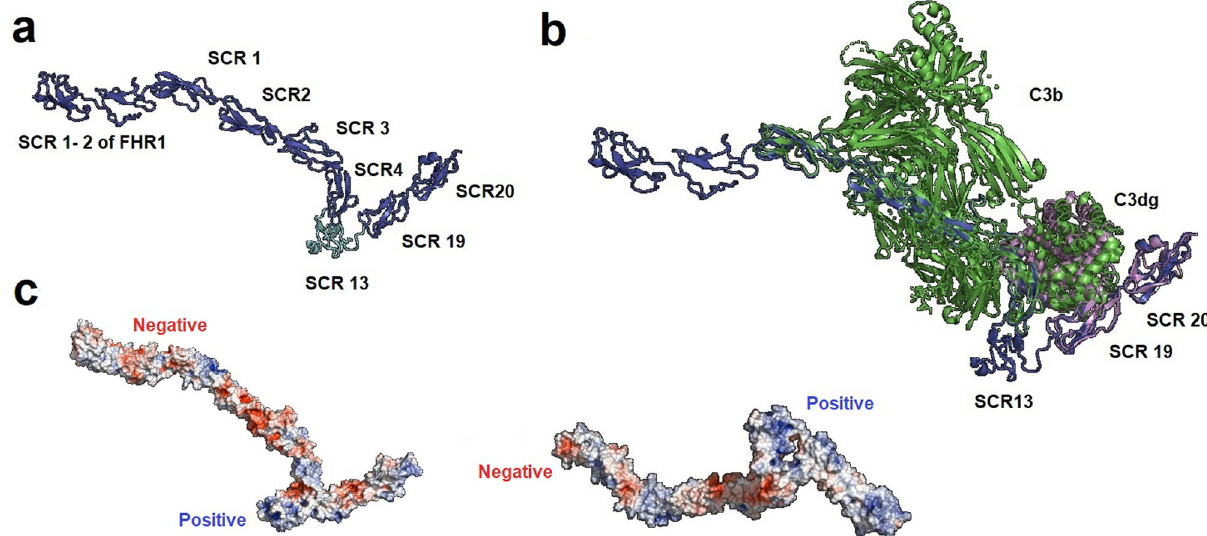
Fig. 3 Comparative protein structure modeling of the fusion protein MFHR13 (FHR1 1-2 :FH 1-4 :FH 13 :FH 19-20 ). a Model of MFHR13 built in Modeller 9.19. b Superimposition of the model MFHR13 (blue) with C3b (green) and C3dg (purple), respectively. Root-mean-square deviation of atomic positions (RMS) between the structure C3b: FH 1-4 (PDB 2WII) and modeled MFHR13 is 1.345. c Electrostatic potential of MFHR13. Electronegative residues are displayed in red, electropositive in blue. The electropositive patch extending over one face of FH 13 to FH 20 is on the right-hand side. The electrostatic potential was determined using Adaptive Poisson-Boltzmann Solver included in PyMOL